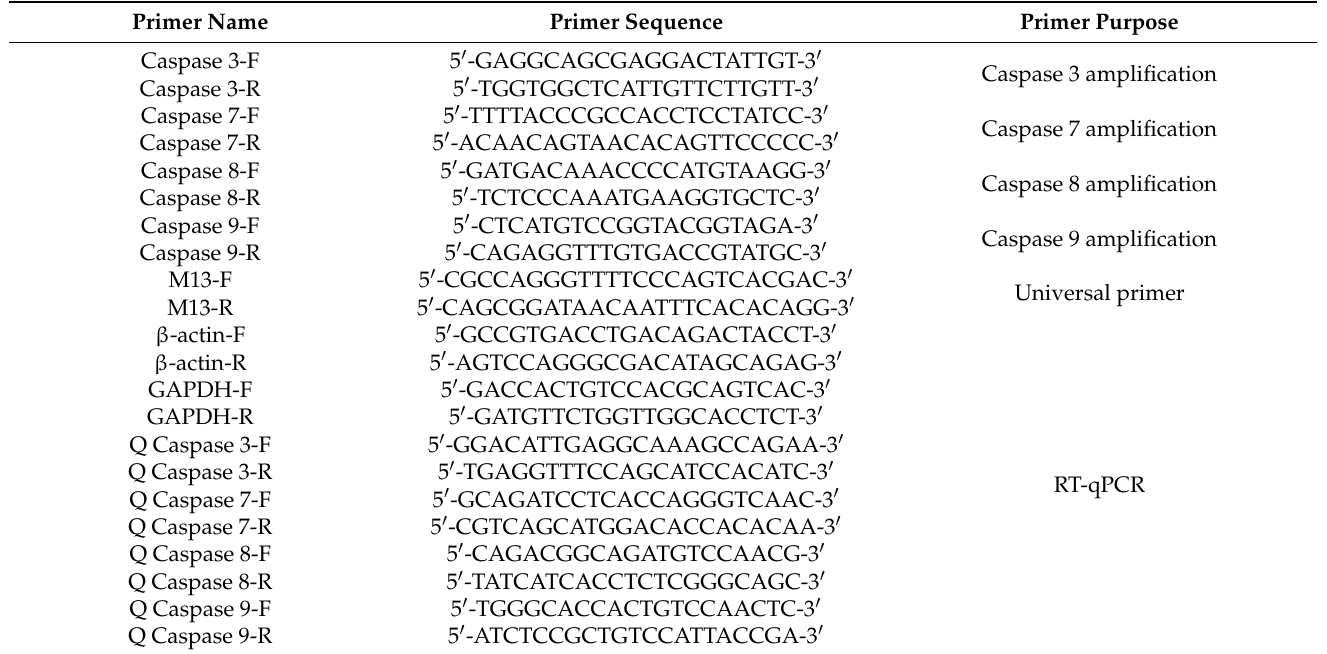
Table 1. Primer sequences were used in this